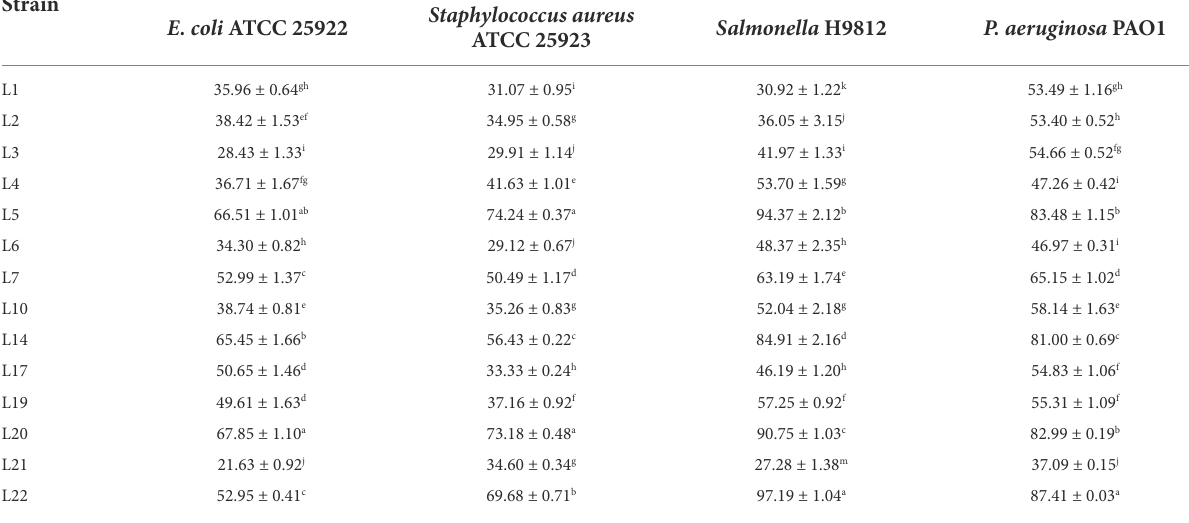
TABLE 2 Co-aggregation abilities of potential probiotic LABs isolated from cow milk. 1